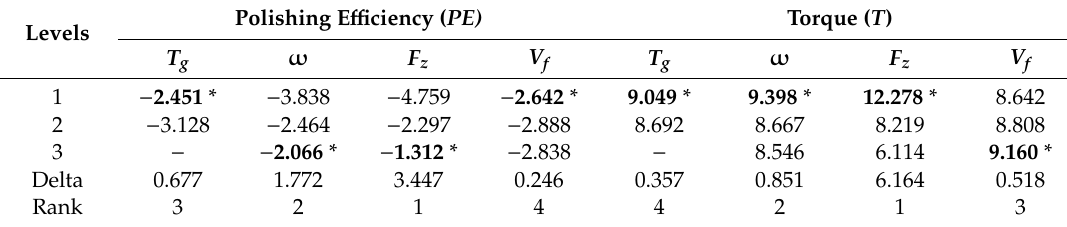
Table 4. Response table for mean S / N